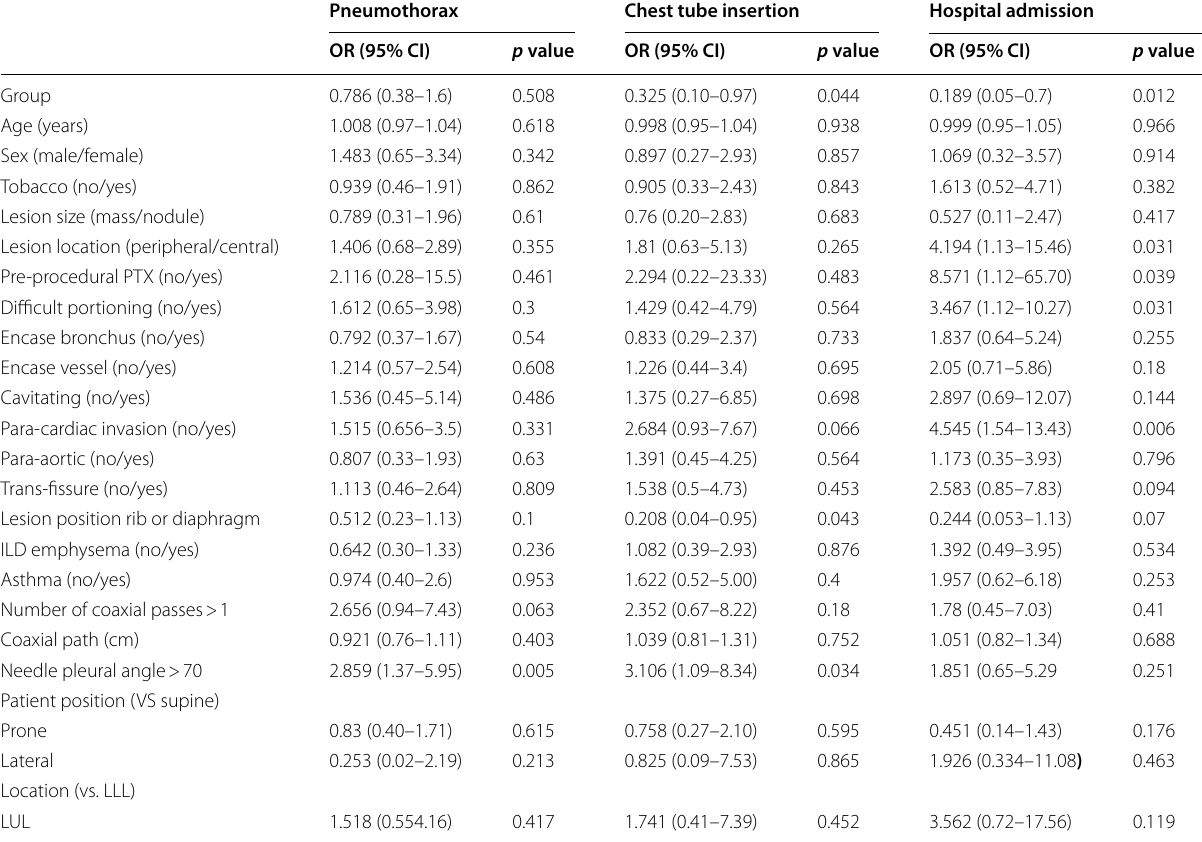
Table 4 Univariate regression analysis of risk factors for pneumothorax rates, chest tube placement, and hospital admission Pneumothorax Chest tube insertion